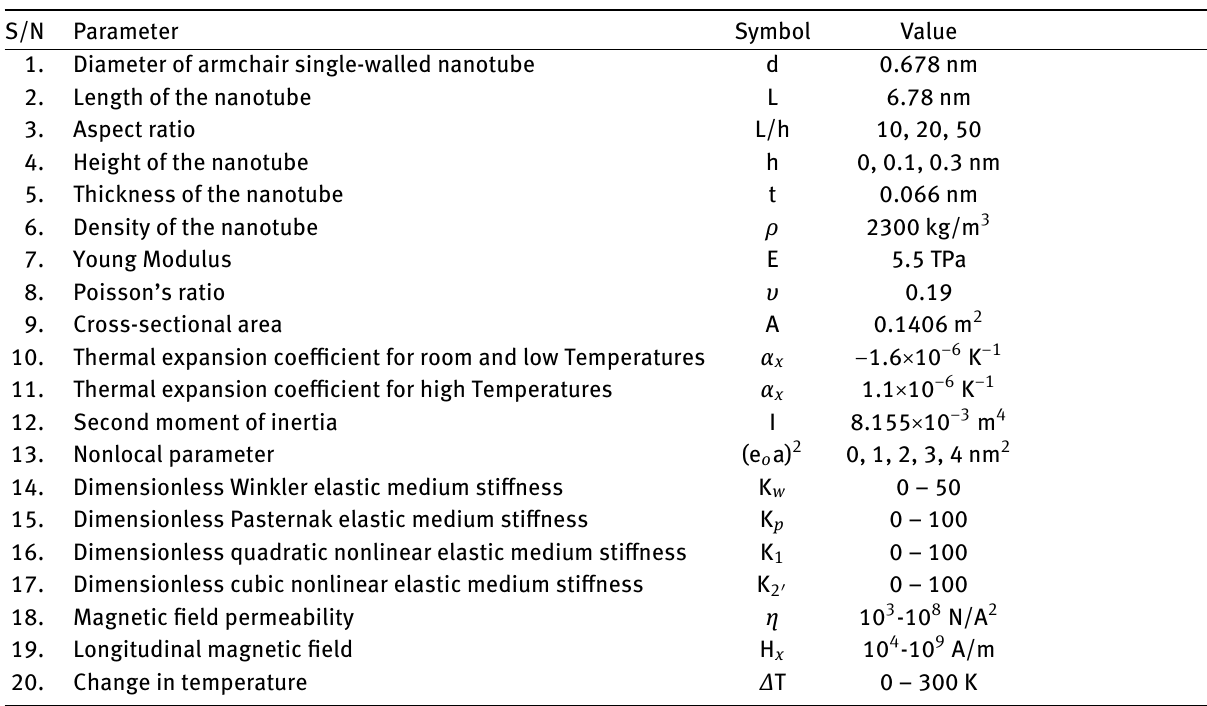
Table 2: Parameters used for simulations